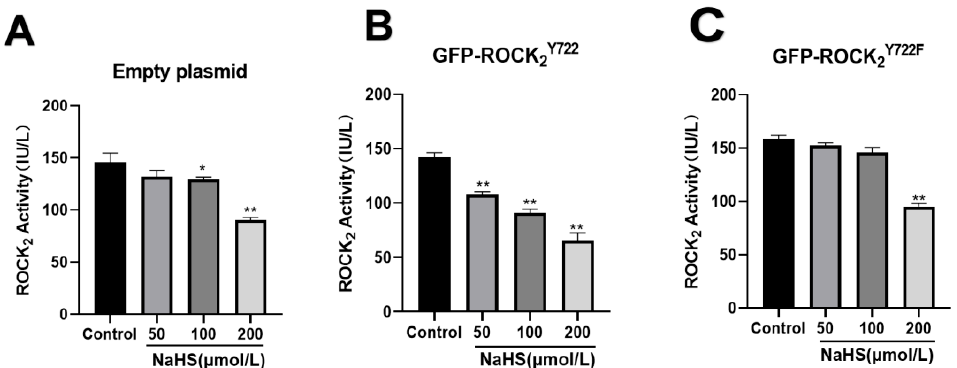
Figure 4. Effects of NaHS on the ROCK 2 activities in the transfected RHNs with the empty plasmid, ROCK 2Y722 -pEGFP-N1 and ROCK 2Y722F -pEGFP-N1, respectively (ELISA, mean ± SEM, n = 3). ( A ) Empty plasmid group. ( B ) GFP-ROCK 2Y722 group. ( C ) GFP-ROCK 2Y722F group. * p < 0.05, ** p < 0.01 vs. control group.